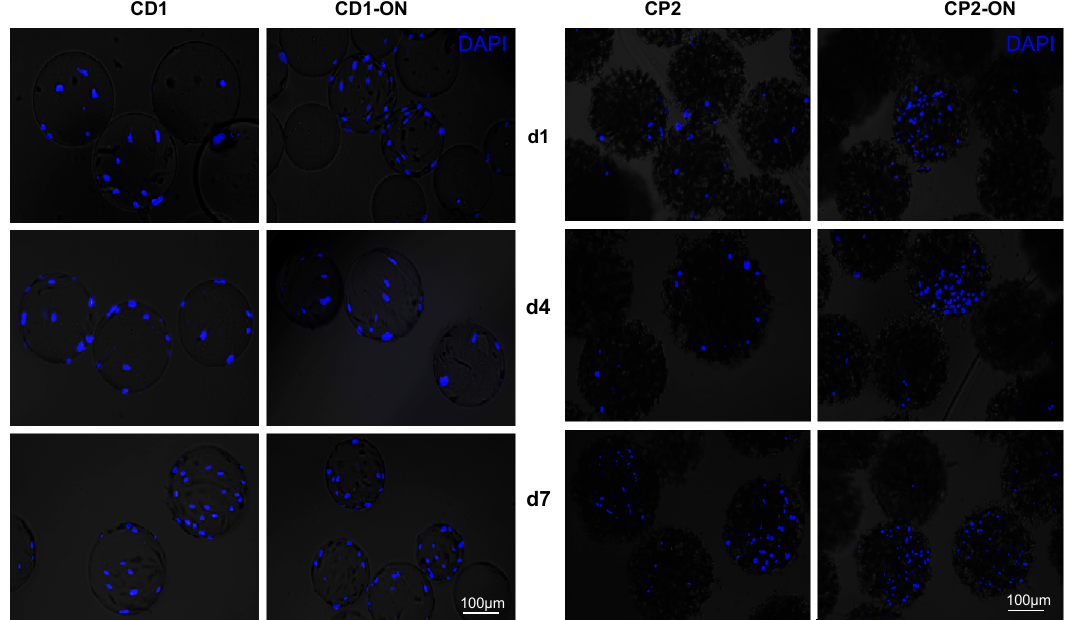
Figure 9. Attachment of DPSCs to the microcarriers after 1, 4 and 7 days of incubation in shake flasks, as visualized by fluorescence microscopy after DAPI staining. Half of the flasks (CD1 and CP2) were immediately shaken in an incubator. The other half of the flasks (CD1-ON and CP2-ON) were left still in the incubator overnight before shaking started, to promote cell adhesion to the microcarriers. The scale bar indicates 100 µ